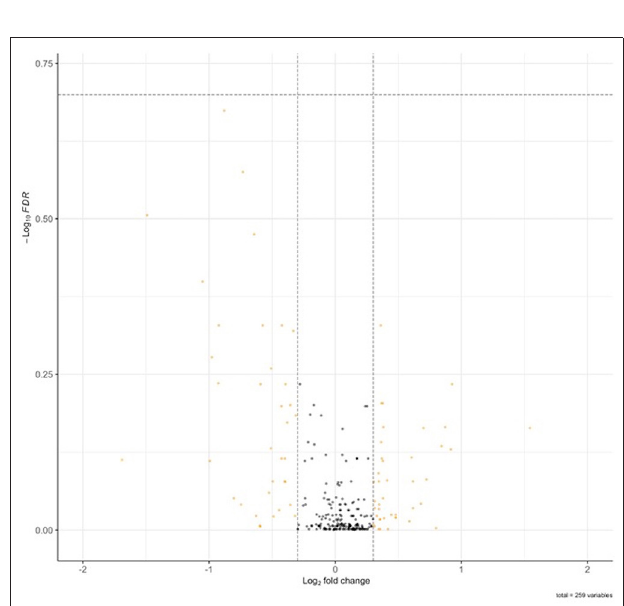
FIGURE 4 | Volcano plot of Ca 2 + associated proteins in fragile X-associated tremor/ataxia syndrome (FXTAS) cortexes. No significant differences in Ca 2 + associated proteins were identified in FXTAS